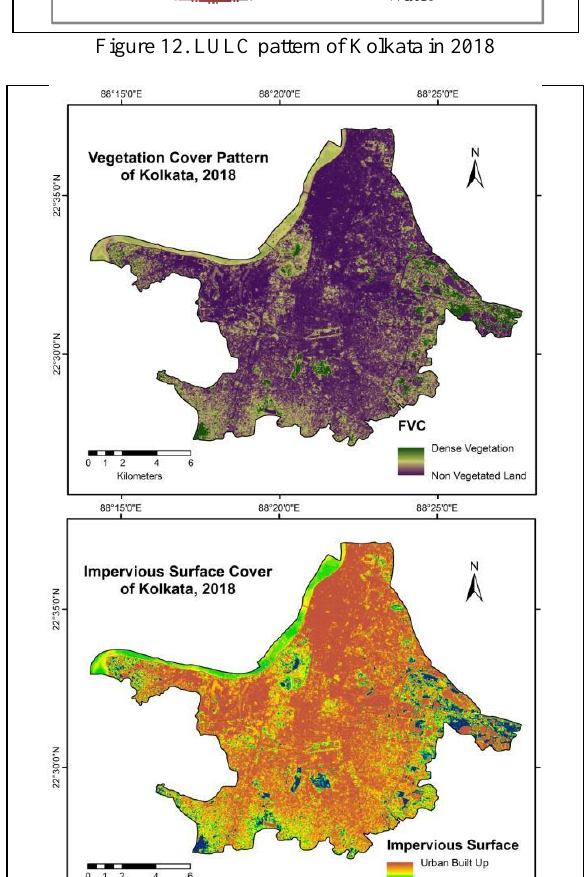
Figure 12. LULC pattern of Kolkata in 2018